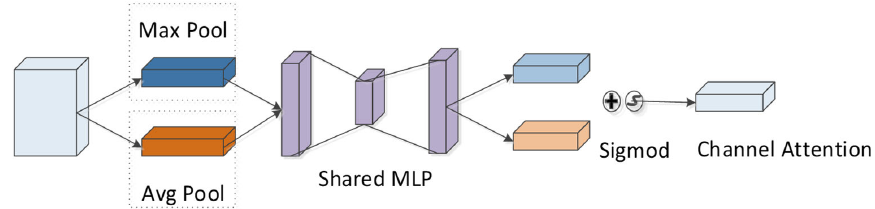
Figure 11. Channel attention module in